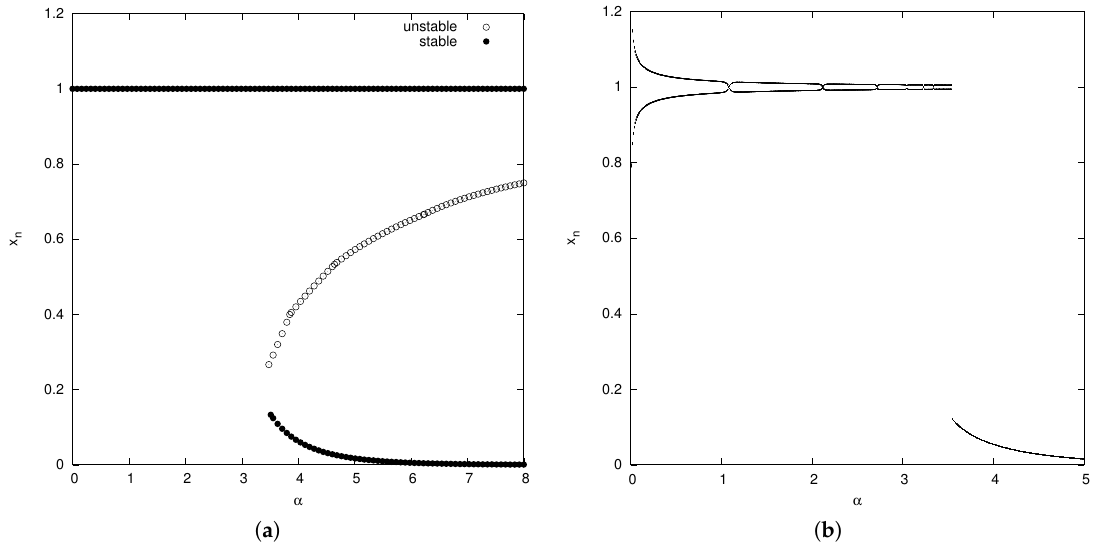
Figure 5. ( a ) Fixed points for System (2) when β = 0. ( b ) Bifurcation diagram with initial condition x 0 = 0.3 and 1000 initial iterations